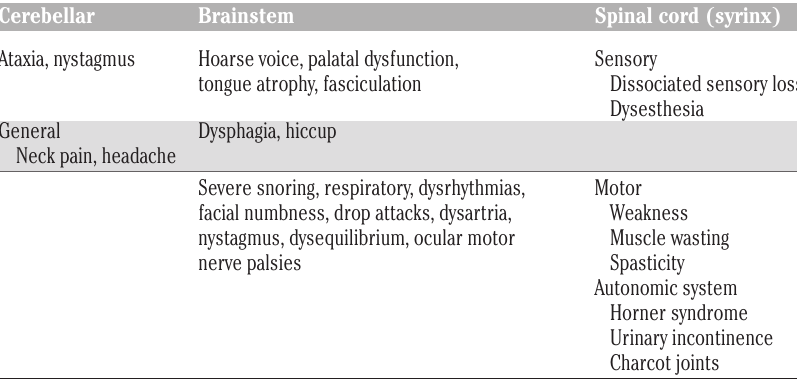
Table 1. Symptomatology of the Chiari I malformation.